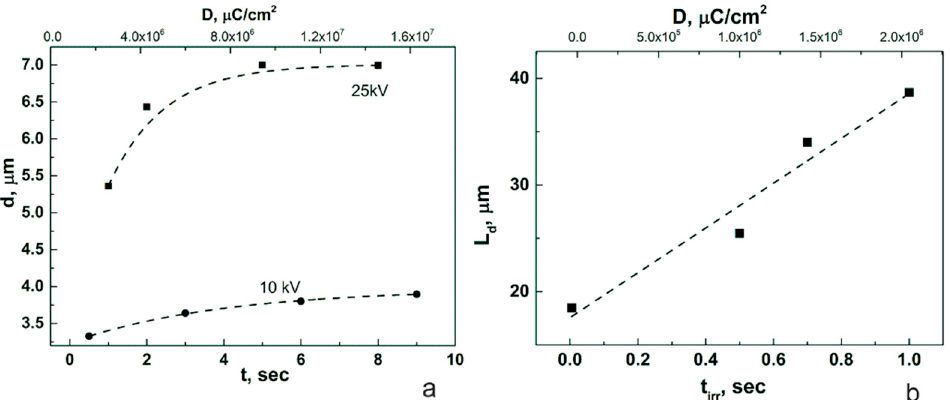
Figure 4. The diameter ( a ) and length ( b ) of domains, written on the polar and nonpolar surfaces, respectively, of zero-field cooled (ZFC) SBN crystals vs. exposure time and dose.In Figure 4b the dashed line shows the linear approximation; the results were obtained at U = 25 kV.